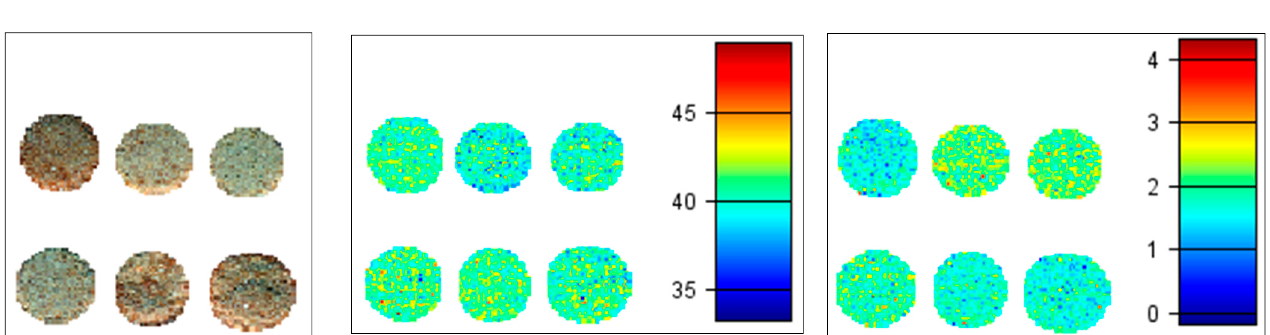
Figure 6. Spatial distribution of carbon (C) and nitrogen (N) concentrations in the test feed samples predicted using full wavelengths of shortwave infrared (SWRI) data. The images were cropped from the original images and the texts in the images were improved for better resolution. The original image is represented in Supplementary Material Figure S2.